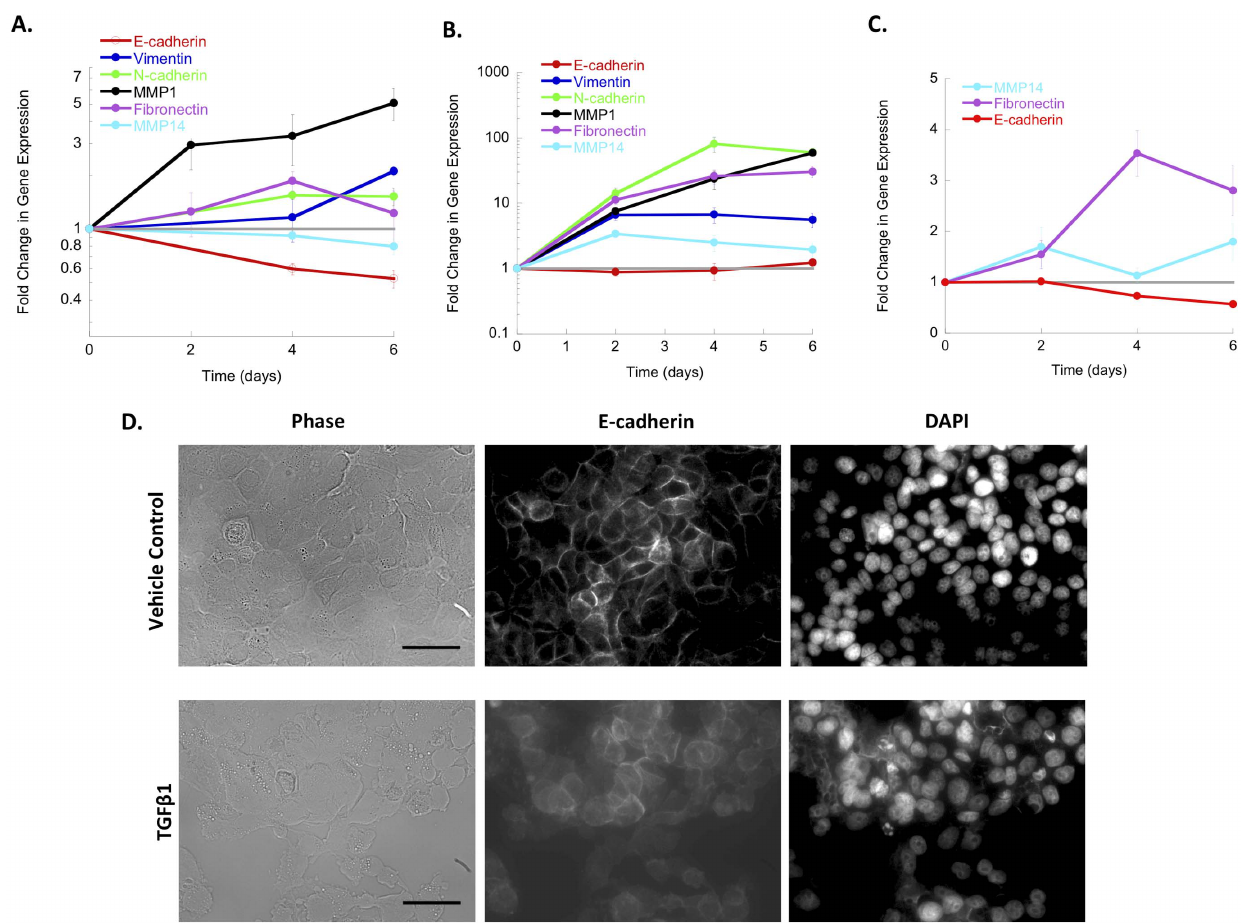
Figure 3. Gene expression changes under array conditions define a time course for studying transcriptional changes in EMT. Gene expression changes in treated cells are shown normalized to levels in vehicle controls (dashed grey line). All differences had reached significance by the end of the six-day time period except for E-cadherin in TGF- b 1 treated HMLE Twist ER. A. Changes in E-cadherin and mesenchymal marker expression in HMLE Twist ER cells treated with 4OHT. B. Changes in E-cadherin and mesenchymal marker expression in HMLE Twist ER cells treated with TGF- b 1. C. Changes in E-cadherin and mesenchymal marker expression in MCF-7 cells treated with TGF- b 1. D. Decreased E-cadherin protein localization at the cell membrane in HMLE Twist ER cells treated with TGF- b 1. Scale bar, 100 m m. Error bars indicate standard error of the mean.